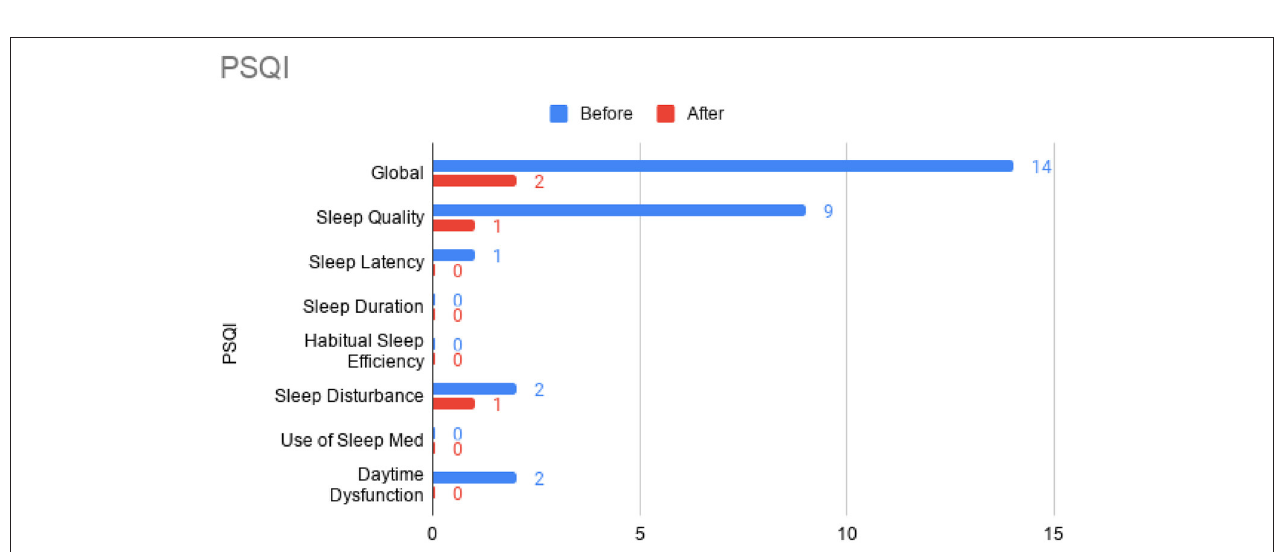
FIGURE 4 | Repetitive Behavior Scale-Revised (RBS-R) sub-scores prior to the initiation of omalizumab (blue) and after the 6 month treatment period (red).